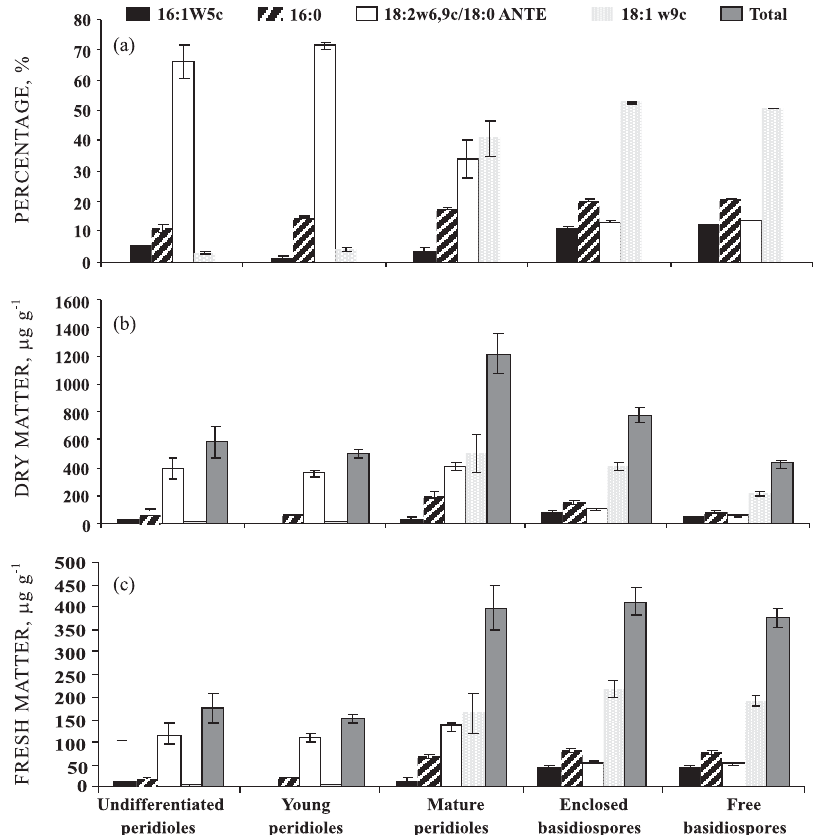
Figure 3. Relative percentage (a) and concentration of the main fatty acids based on dry and fresh matter during different developmental stages of the peridioles that constitute the basidiocarps of Pisolithus sp (b) and (c). Bars represent standard